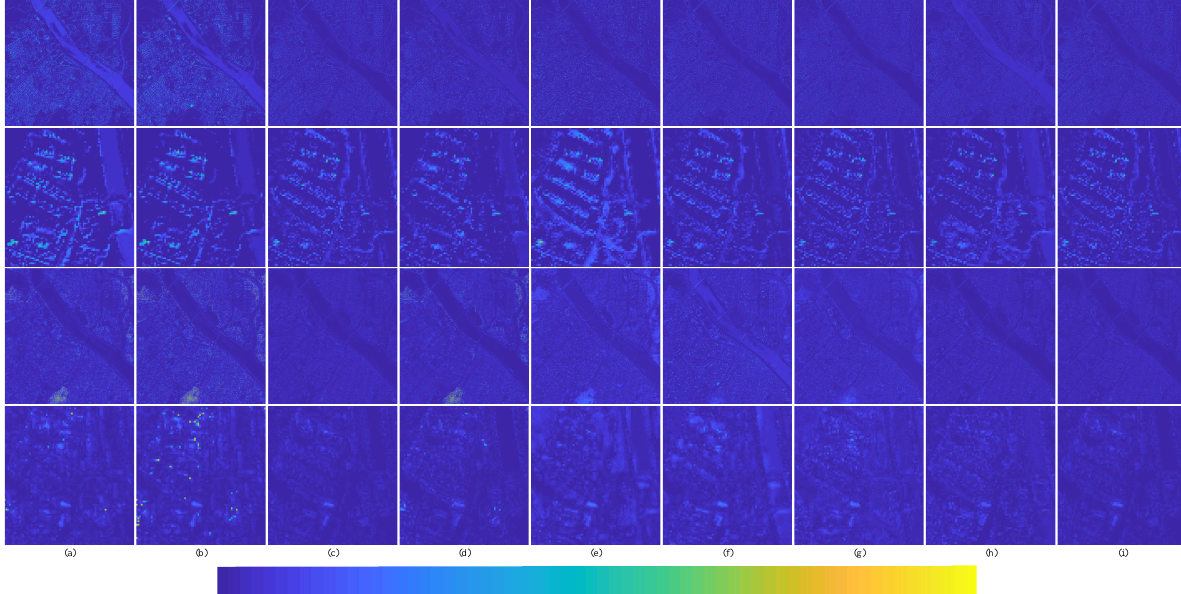
Figure 22. Average intensity difference maps and average spectral difference maps between pan-sharpened MS image and ground-truth MS image for testing dataset GF-2 with reduced resolution; the top row are the average intensity difference maps of the whole image, the second row are the average intensity difference maps of the enlarged area in Figure 21, the third row are the average spectral difference maps of the whole image, the bottom row are the average spectral difference maps of the enlarged area in Figure 21. ( a ) Brovey; ( b ) GS; ( c ) SFIM; ( d ) IFCNN; ( e ) PNN; ( f ) DRPNN; ( g ) PanNet; ( h ) ResTFNet; ( i ) RDFNet